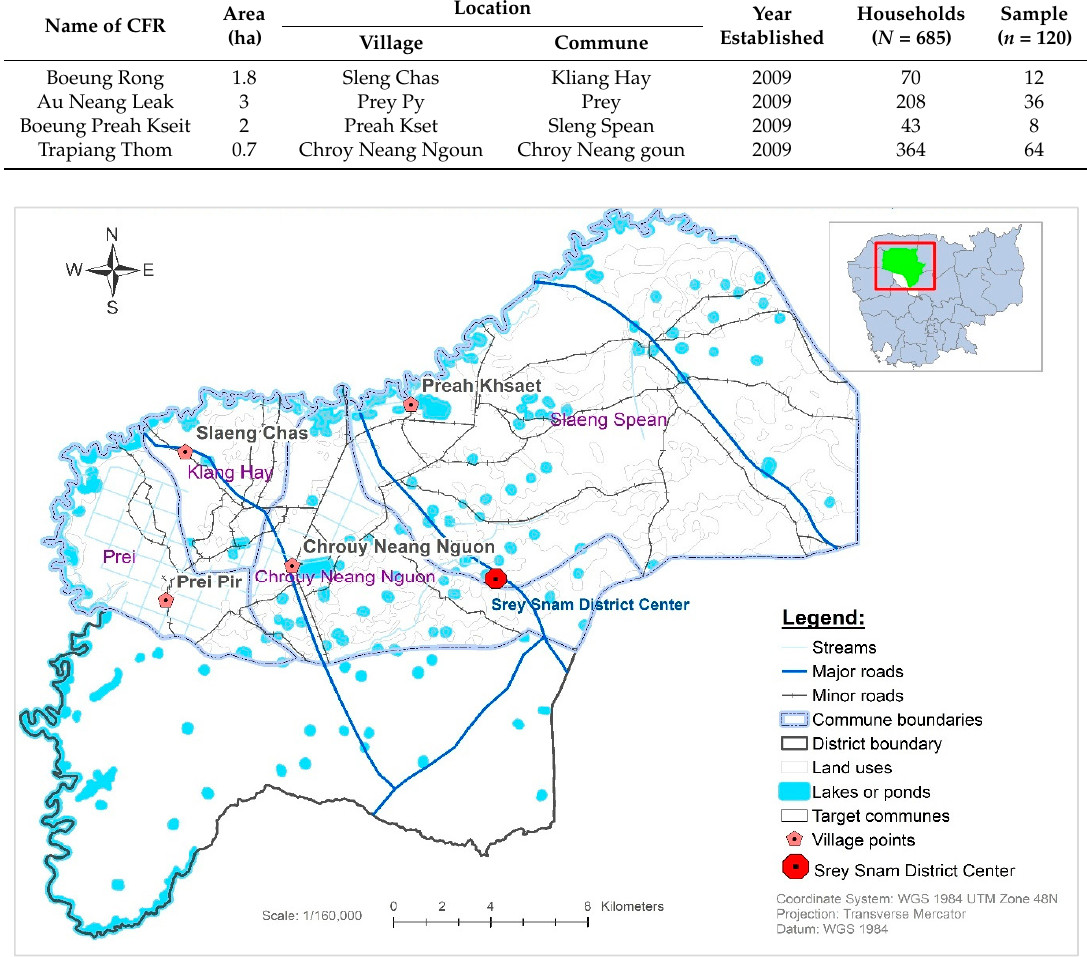
Figure 1. Map showing study sites.